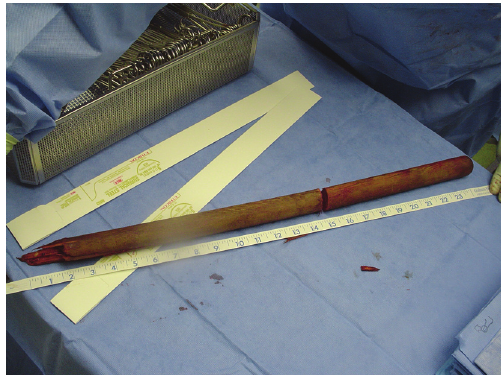
Figure 4: The extracted wooden rod measured 63.5 cm in